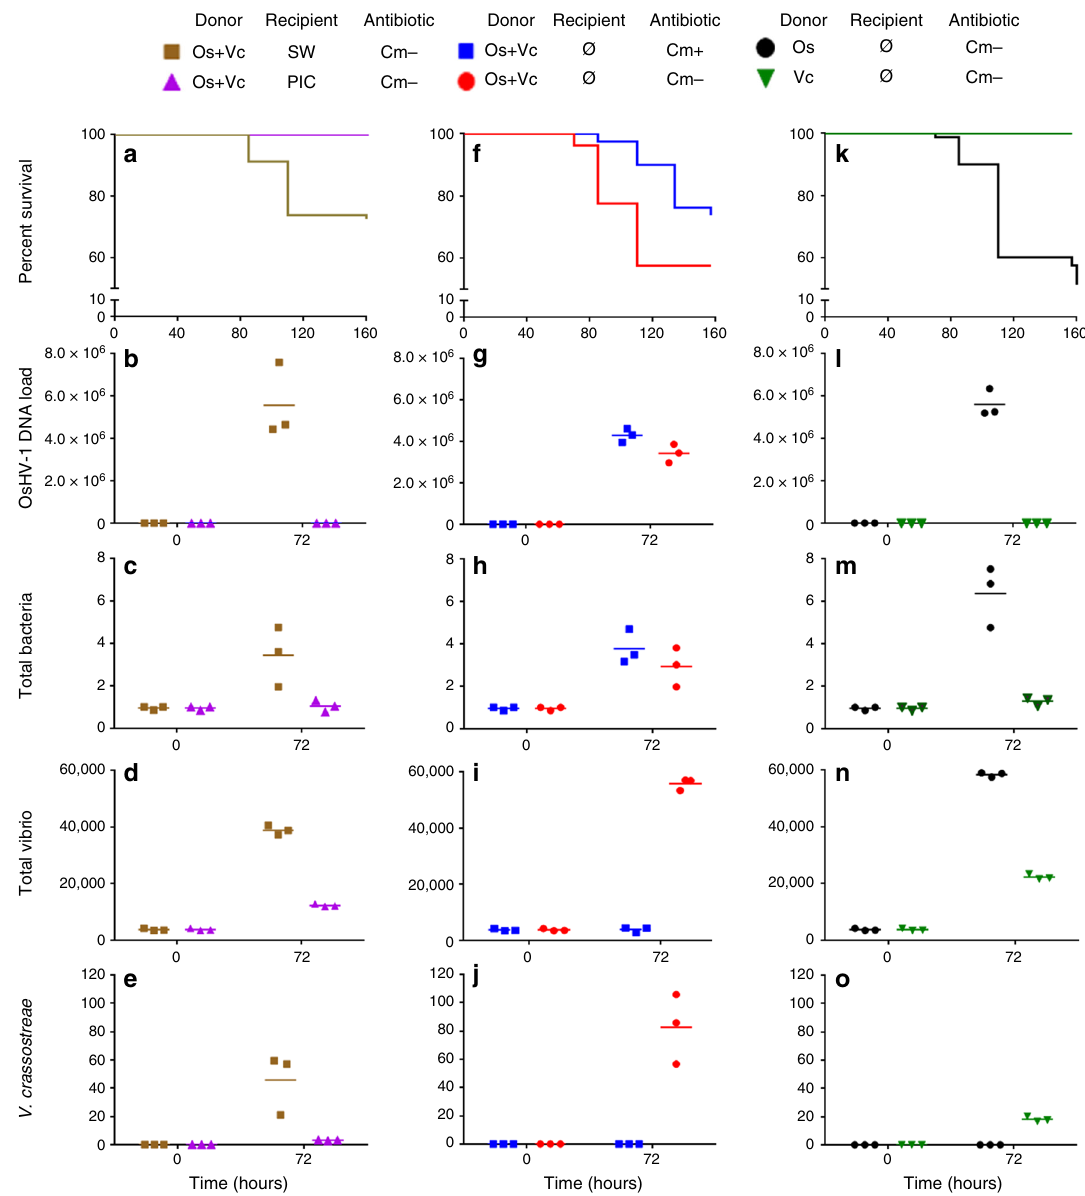
Fig. 10 Rationalized experimental infections demonstrate that OsHV-1 replication is required for bacterial colonization and oyster death. Experimental infection by OsHV-1 and/or V . crassostreae was performed as follows: oyster donors were injected with either 3.88 × 10 8 genomic units of OsHV-1 (Os) or 5 × 10 7 cfu V . crassostreae (Vc). a – e Recipient oysters were injected with poly(I:C) (PIC) or sterile seawater (SW) before exposition to both Vc and Os donors. f – j Recipients were exposed to both Os and Vc donors in the presence (Cm + ) or absence (Cm − ) of chloramphenicol in the tanks. k – o Recipients were exposed to Os or Vc donors. The OsHV-1 DNA load (viral genomic units per ng of total oyster DNA), relative quanti fi cation of total bacteria, and total Vibrio and Vibrio crassostreae abundance were measured by qPCR. No mortality was observed, and no OsHV-1 DNA was detected in recipient oysters when untreated donors were used as a control. Each dot represents a measure done on a distinct pool of 10